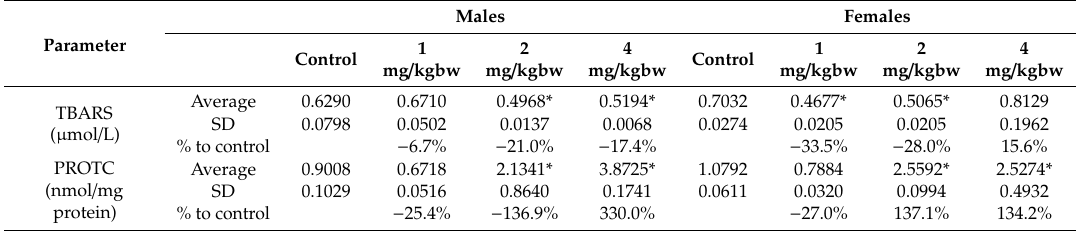
Table 4. Markers at 28 days after exposure to di ff erent concentrations of